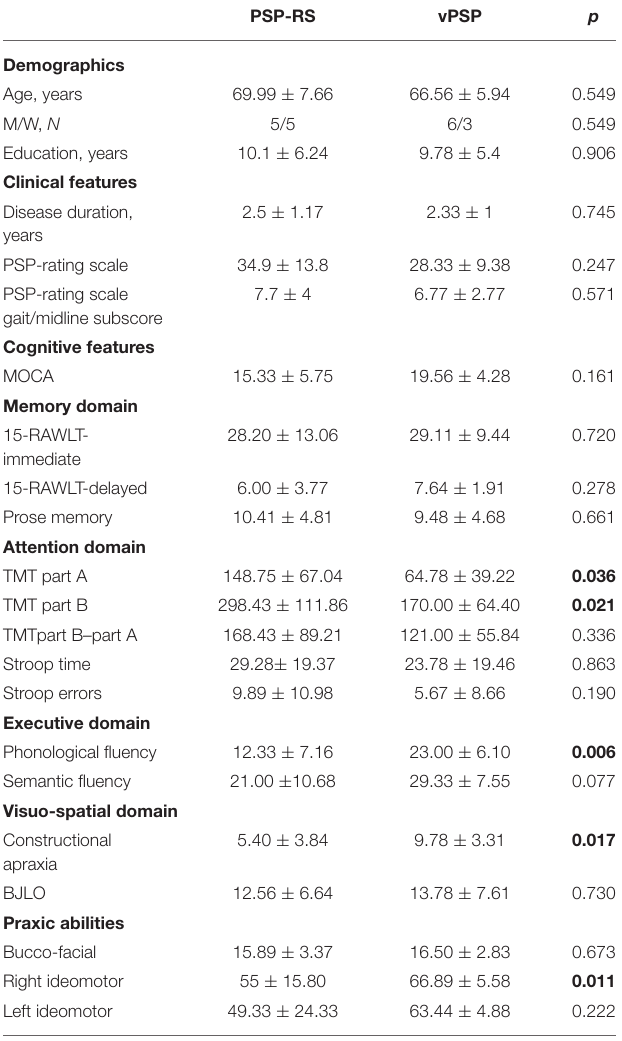
TABLE 1 | Demographic, clinical and cognitive features according to PSP